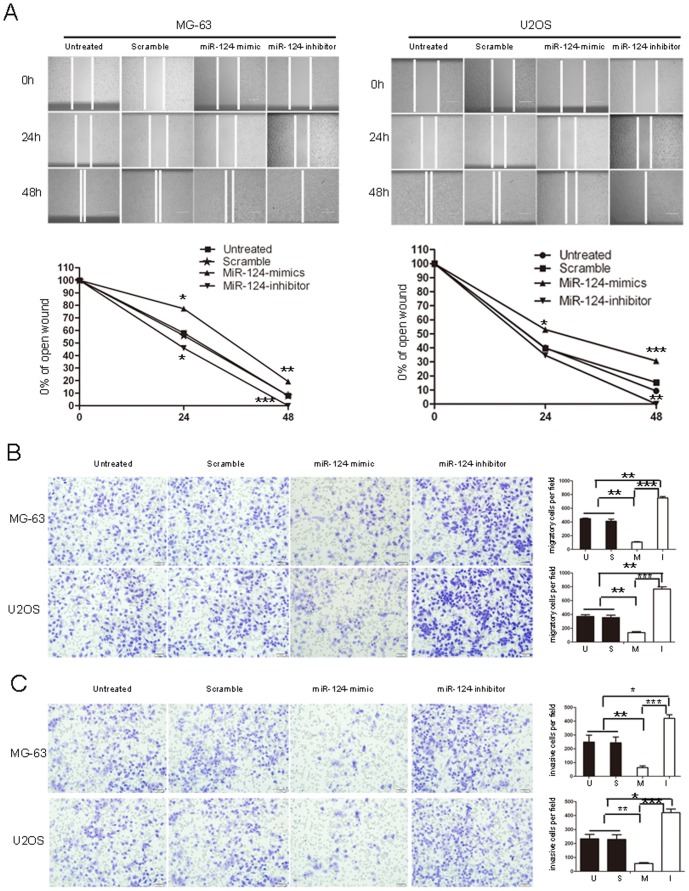
Overexpression of miR-124 inhibits osteosarcoma cell migration and invasion.(A) MG-63 and U2OS cells were not transfected or transfected with 50 nmol/L of miR-10b mimics or sramble or inhibitor for 24 hours, and wounds were made. The relative ratio of wound closure per field is shown. (B) (C) MG-63 and U2OS cells were not transfected or transfected with 50 nmol/L of miR-10b mimics or sramble or inhibitor for 24 hours, and migration (B) or transwell invasion (C) assay was performed. The relative ratio of invasive cells per field is shown. Magnification for identification of migration is ×400 and invasion ×40. All data is shown as mean±SD. *p<0.05, **p<0.01 and ***p<0.001.